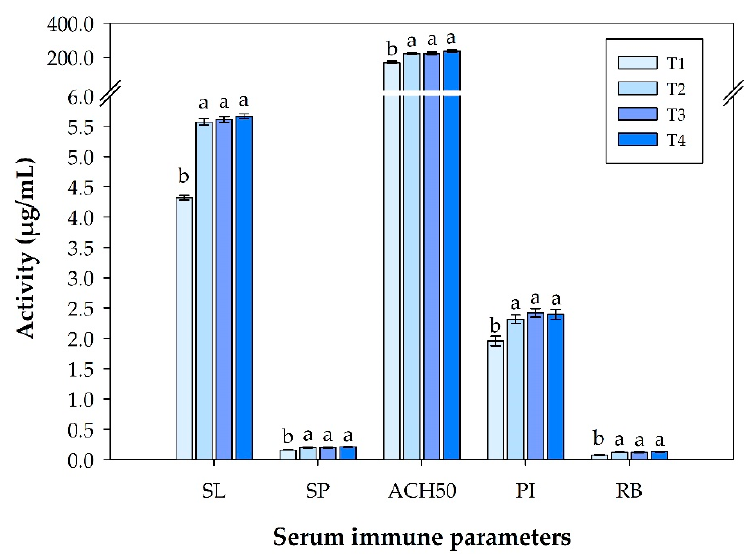
Figure 2. Serum immunity parameters of Nile tilapia post-vaccination ( µ g mL − 1 ). Treatment 1 (T1)—control, Treatment 2 (T2)—formalin-killed S. agalactiae immersion vaccine, Treatment 3 (T3)— formalin-killed S. agalactiae injectable oil-based vaccine, Treatment 4 (T4)—formalin-killed S. agalactiae water-based oral vaccine. The presence of different letters in each group indicates a significant difference ( p < 0.05). SL, serum lysozyme activity; SP, serum peroxidase activity; ACH50, alternative complement activity; RB, respiratory burst activity; PI, phagocytosis